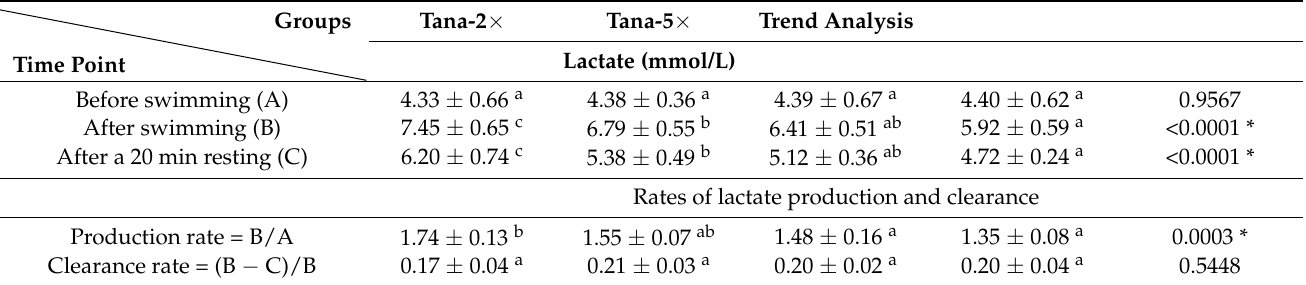
Table 1. Effect of Tana on lactate